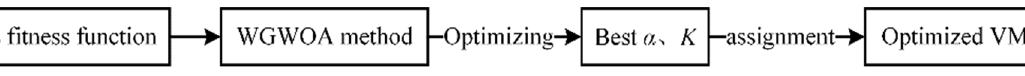
Figure 1. Flowchart of VMD optimization based on the WGWOA algorithm.